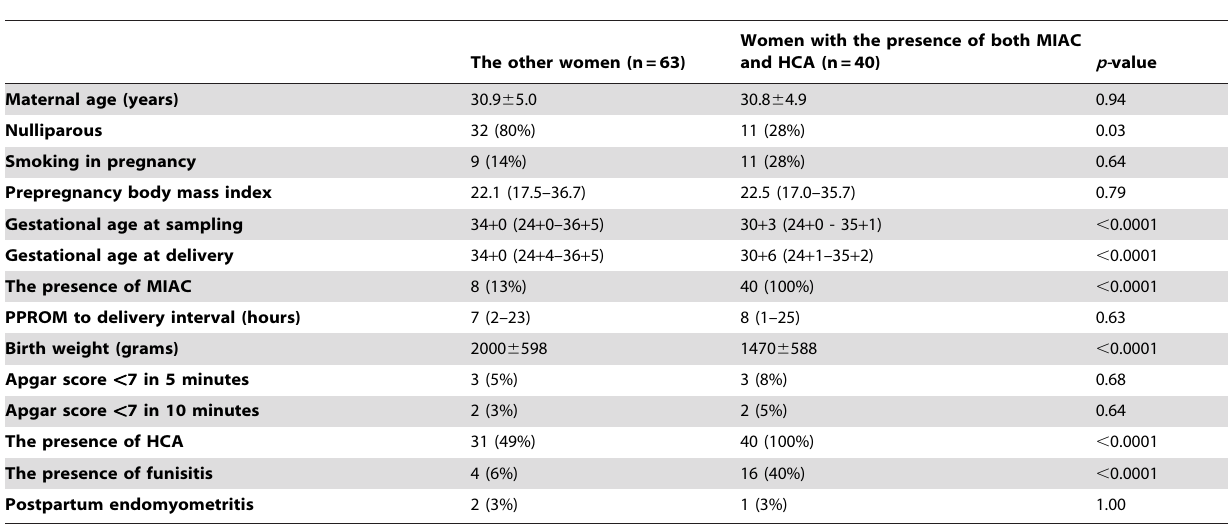
Table 2. Demographic and clinical characteristics of the women and newborns involved in the replication